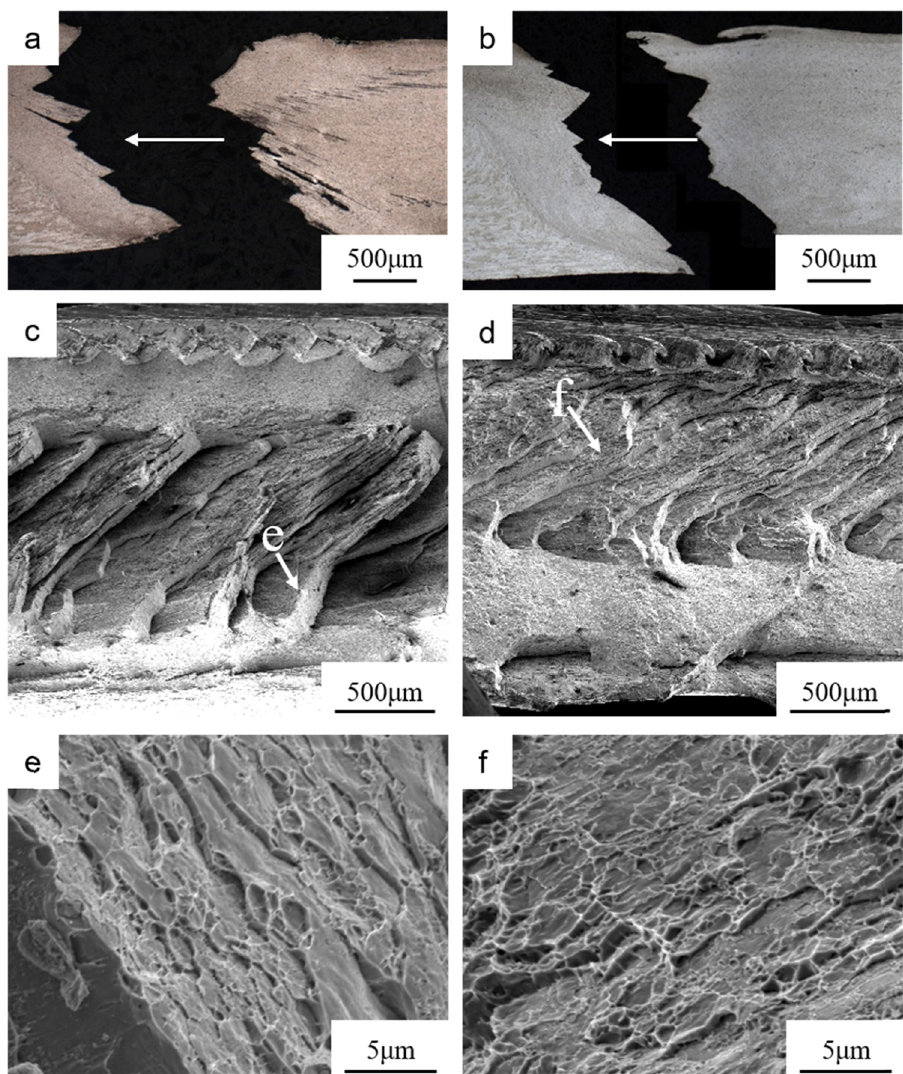
Figure 12: OM of as - tested ( a ) A3 and ( b ) B3 specimens and observation direction of SEM indicated by white arrow; SEM of fracture surface with M3: ( c ) A3 tensile specimen and ( d ) B3 tensile specimen; ( e ) local zone indicated by white arrow in ( c ) rotated counterclockwise about 70° for better observation; ( f ) local zone indicated by white arrow in ( d ) .